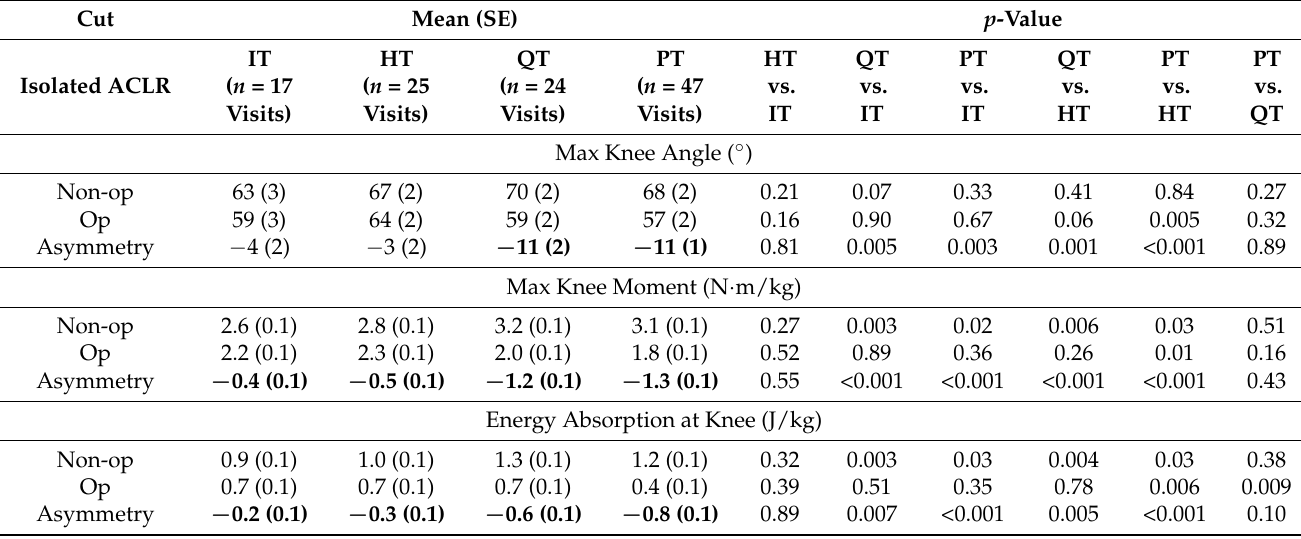
Table A2. Comparison of sagittal knee kinematics/kinetics for operative and non-operative limbs during cutting for patients with isolated ACLR (no concomitant meniscus procedure).